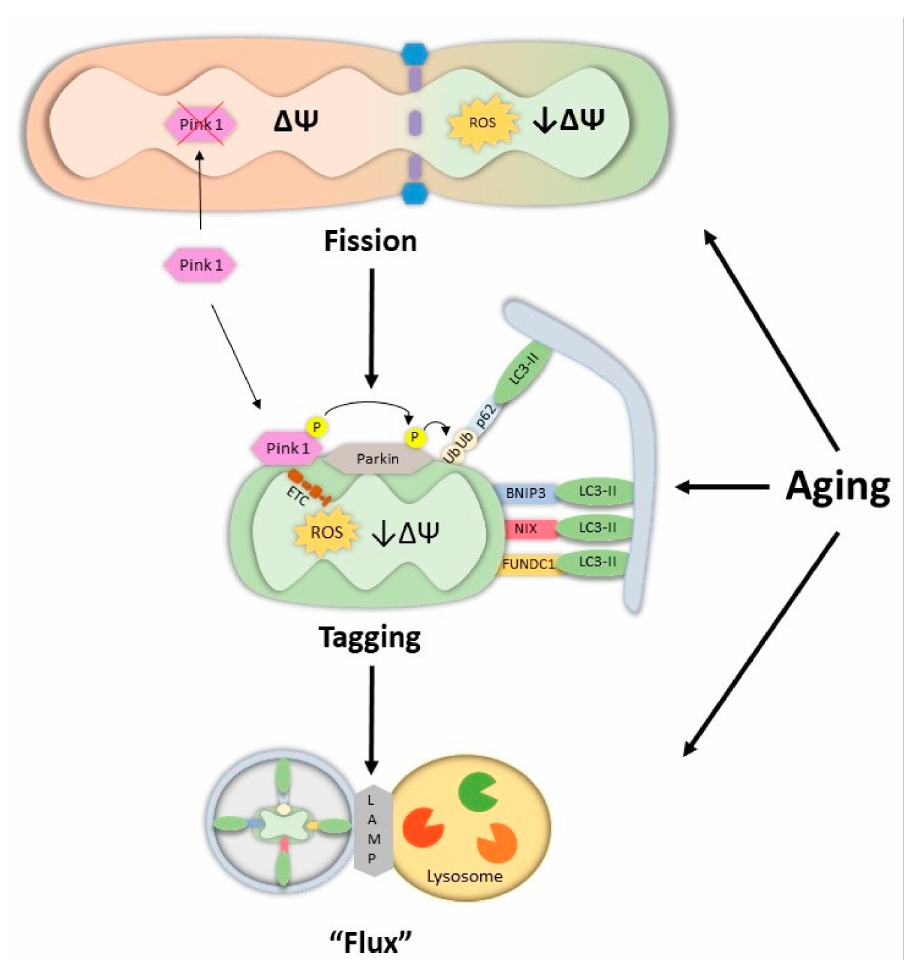
Figure 2. The impact of age on mitophagy in skeletal muscle. When a portion of the mitochondrial reticulum becomes dysfunctional, with a low membrane potential ( Ψ ) and elevated ROS produc- tion, it will undergo fission, mediated by Drp1 and Fis1, depicted as green mitochondria. The fragmented mitochondrion will enter the mitophagy pathway. Pink1, which is normally imported and degraded in the mitochondria, will accumulate on the outer mitochondrial membrane (OMM), and will ultimately recruit and activate the E3-Ligase Parkin. Parkin subsequently poly-ubiquitinates OMM proteins which bind to adapt proteins such as p62. p62 will tether autophagosomal proteins, such as LC3-II. In Ub-independent mitophagy, receptors such as BNIP3, NIX and FUNDC1, found on the OMM, will anchor the mitochondria directly to autophagosomal proteins. Ultimately the autophagosome-bound mitochondria will be shuttled to lysosomes where they will be degraded. Aging muscle exhibits increased mitochondrial fission, autophagy tagging, and flux, to the point of the lysosomes. Evidence, somewhat limited, exists that point to lysosomal dysfunction with age. The vitality of these fusion and fission regulatory proteins has been revealed using ge- netic models. For example, knockdown of the pro-fission proteins Fis1 and Drp1 propagates muscle atrophy [146–148], promotes hyperfused mitochondria with impaired function [149] and perturbs mitophagy [148,149]. These data suggest that fission is required to maintain muscle organellar health via the provision of dysfunctional mitochondria through mi- tophagy pathway. With regard to fusion, Mfn2 [129,150] and Opa1 [151] deletion promotes mitochondrial fragmentation, excessive ROS production and muscle atrophy. In combi- nation, these results suggest that a balance of fusion and fission is required to maintain a healthy mitochondrial pool, which has implications for muscle health with